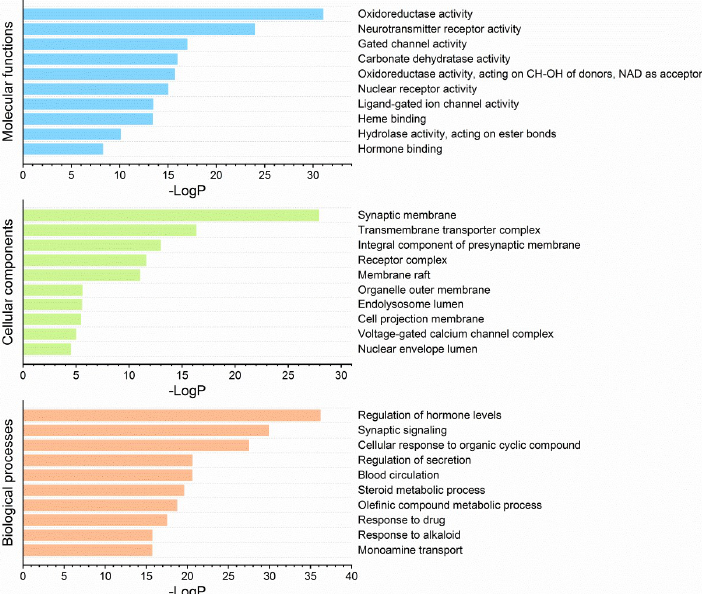
Figure 7. Enrichment analysis on GO molecular functions, cellular components and biological processes that demonstrates the representative top 10 enriched terms.